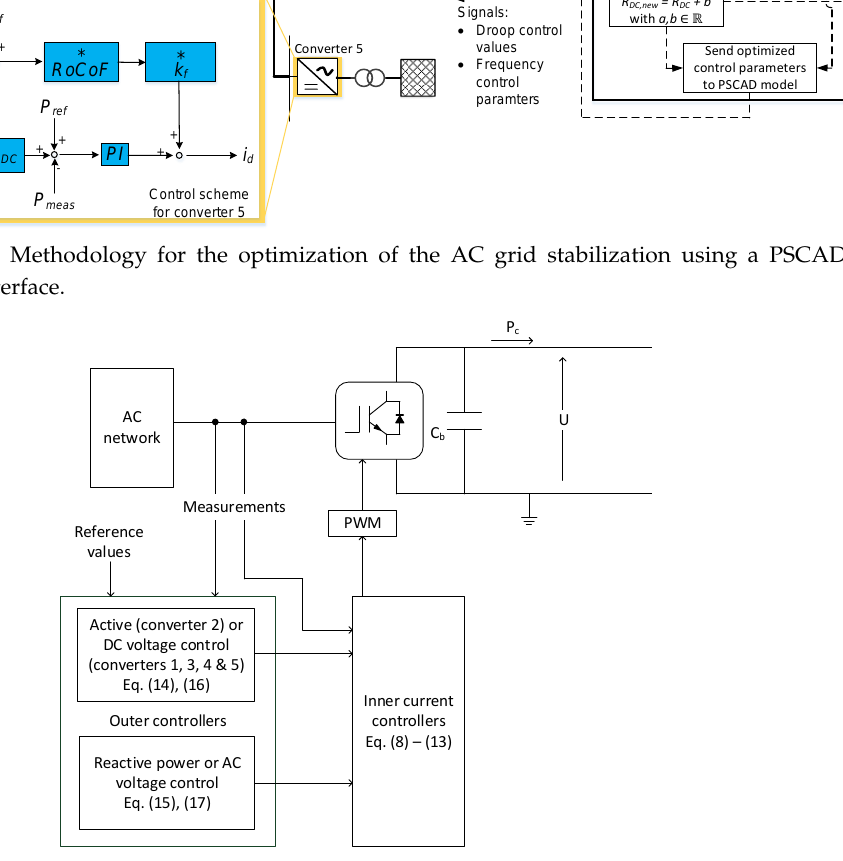
Figure 5. Overall converter control